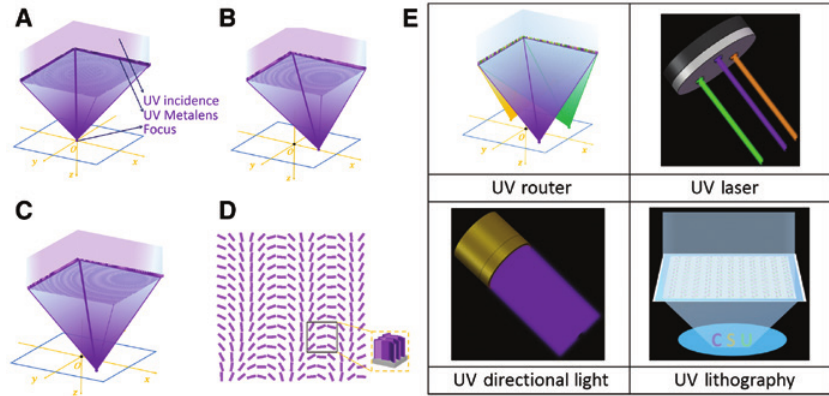
Figure 1: Overviews of the principle and application of a metalens. Schematics of the UV metalenses with in-plane on-axis (A), off-axis (B) and out-of-plane (C) focusing configurations. The UV metalens is formed by nanorods with varied rotation, which has a ripple-like pattern. (D) Schematic of the UV metalens, with the inset denoting the stereogram of the nanorods. (E) Overview of the applications of the UV